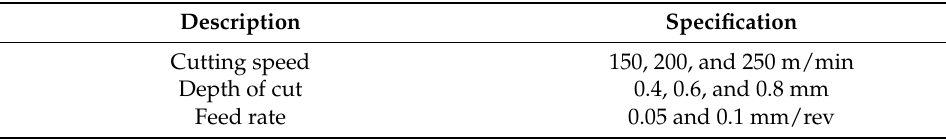
Table 6. Cutting conditions used in the experiment.